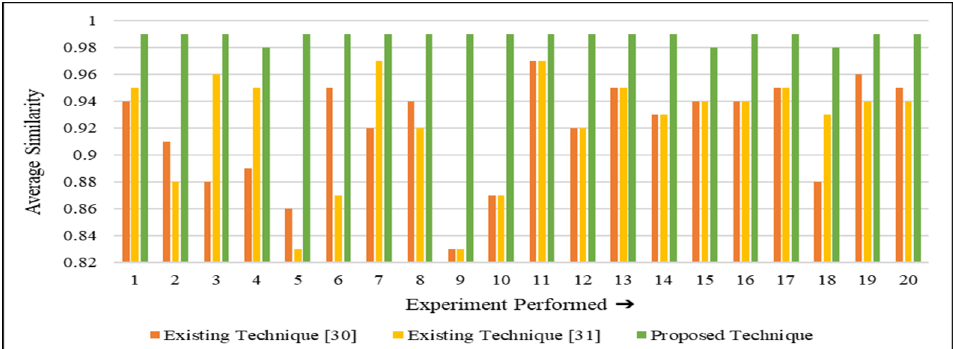
Fig. 6: Imperceptibility Analysis with Existing Techniques